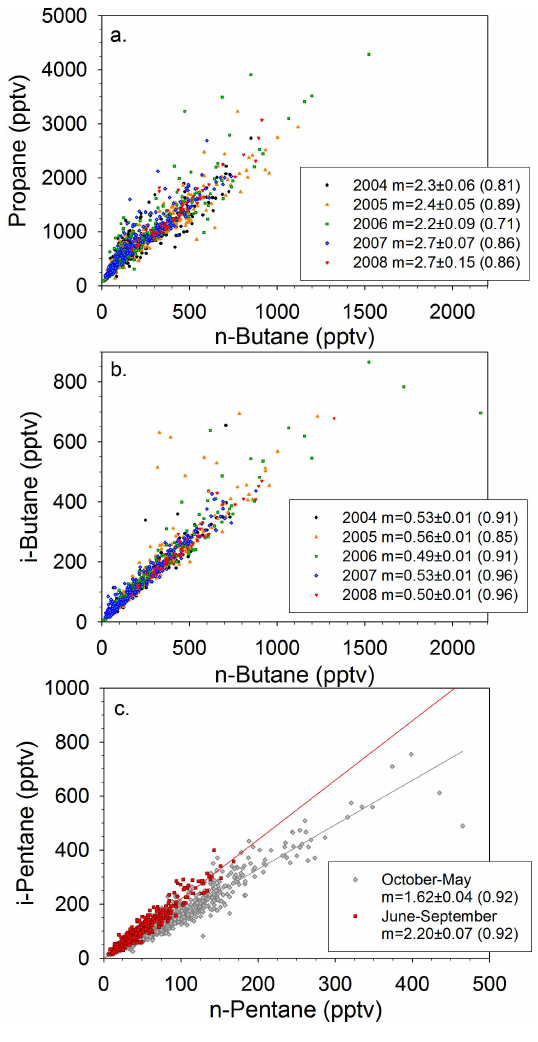
Fig. 7. Correlation ( m =slope ± standard error ( r 2 )) of n-butane with (a) propane and (b) i-butane for each year. (c) Correlation be- tween n-pentane and i-pentane. Gray diamonds are all of the sam- ples collected in October–May of 2004–2008. Red squares are all of the samples collected in June–September of